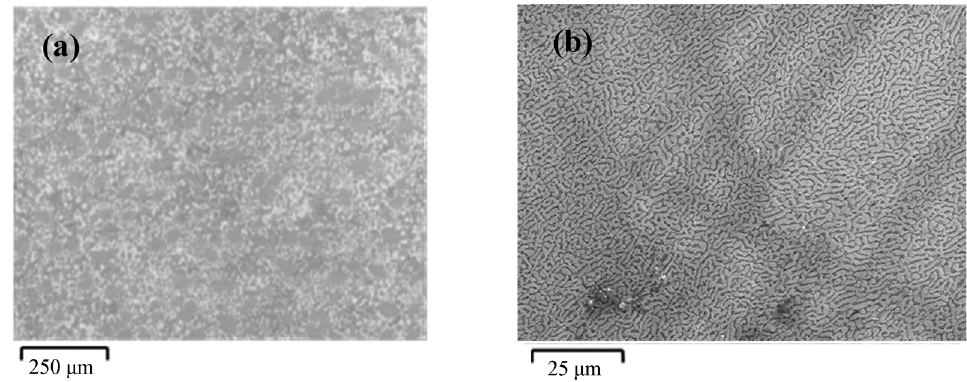
Figure 4: SEM image of alloys with obtained eutectic compositions. ( a ) Al – Si – Cu – Mg – Zn and ( b ) Zn – Al – Mg – Sn.